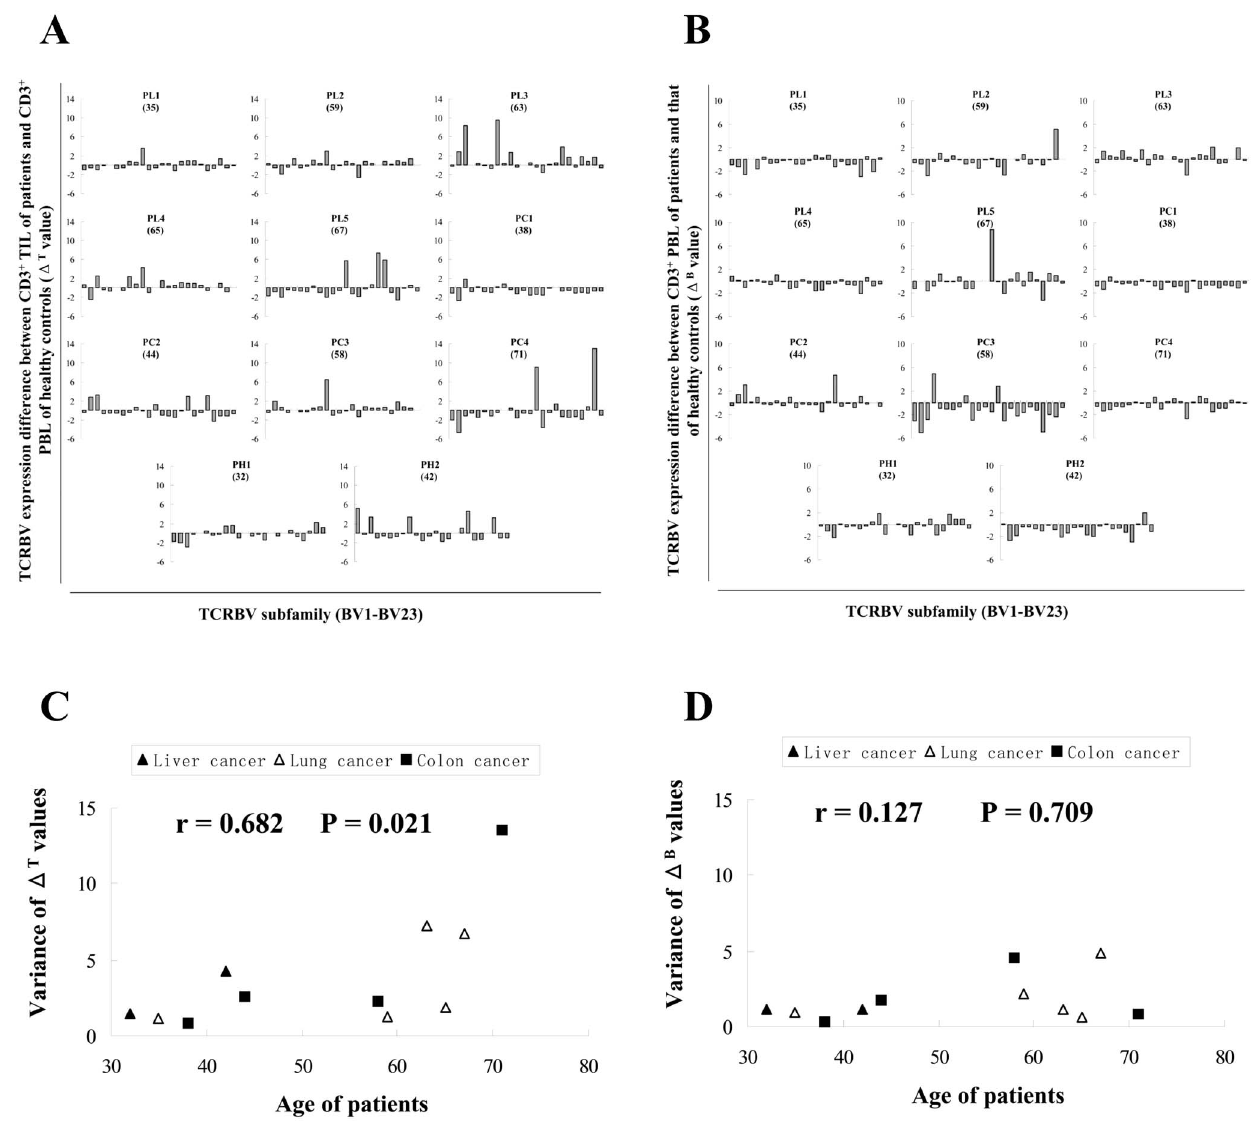
Figure 3. Analysis of expression difference of TCR-V b repertoire between TIL or PBL of cancer patients and PBL of healthy controls. The expression level of each TCRBV subfamily in PBL or TIL of each patient was separately compared with the mean of the counterparts in PBL of healthy controls. ( A ) D T values (the percentage of each TCR-V b subfamily in CD3 + TIL of patient minus the mean percentage of the counterpart in CD3 + PBL of healthy controls) were calculated to generate the histograms. ( B ) The variances of D T values for each patient were calculated and matched with the ages, and the correlation coefficient (r) and P value (P) were computed. ( C ) D B values (the percentage of each TCR-V b subfamily in CD3 + PBL of patient minus the mean percentage of the counterpart in CD3 + PBL of healthy controls) were calculated to generate the histograms. ( D ) The variances of D B values for each patient were calculated and matched with the ages, and the correlation coefficient and P value were subsequently computed. The numbers in brackets are the ages of patients.